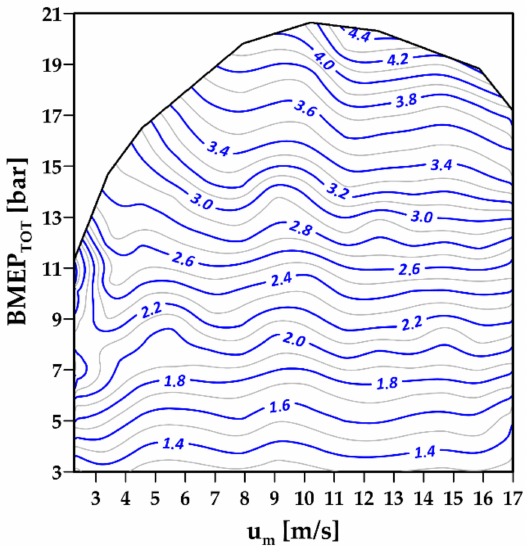
Figure 14. Optimal exhaust pressure levels as function of load and speed ( T 4 /T 1 = 4.5, η T =